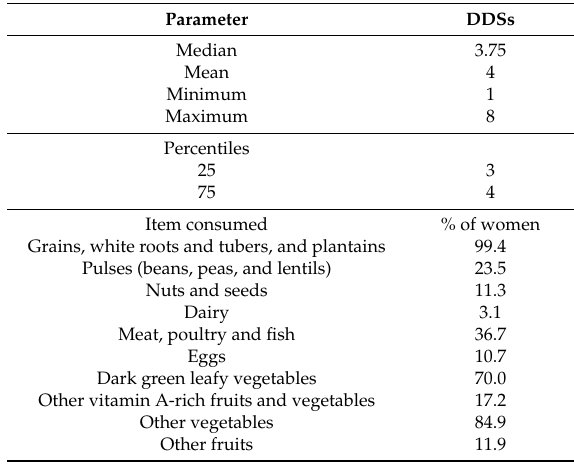
Table 2. Dietary diversity scores (DDS) and percentage of